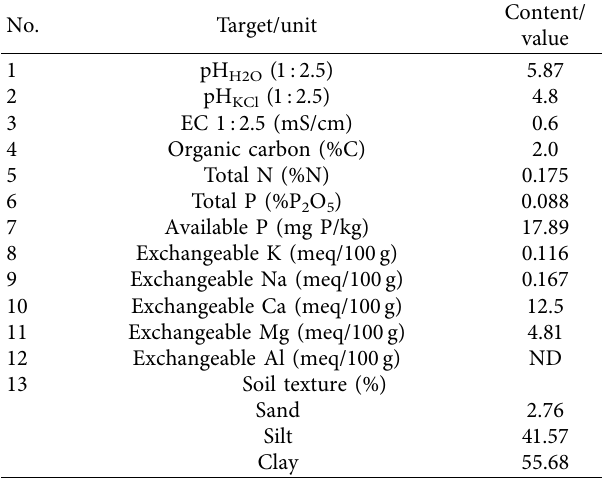
Table 2: Some physicochemical parameters of rice-growing